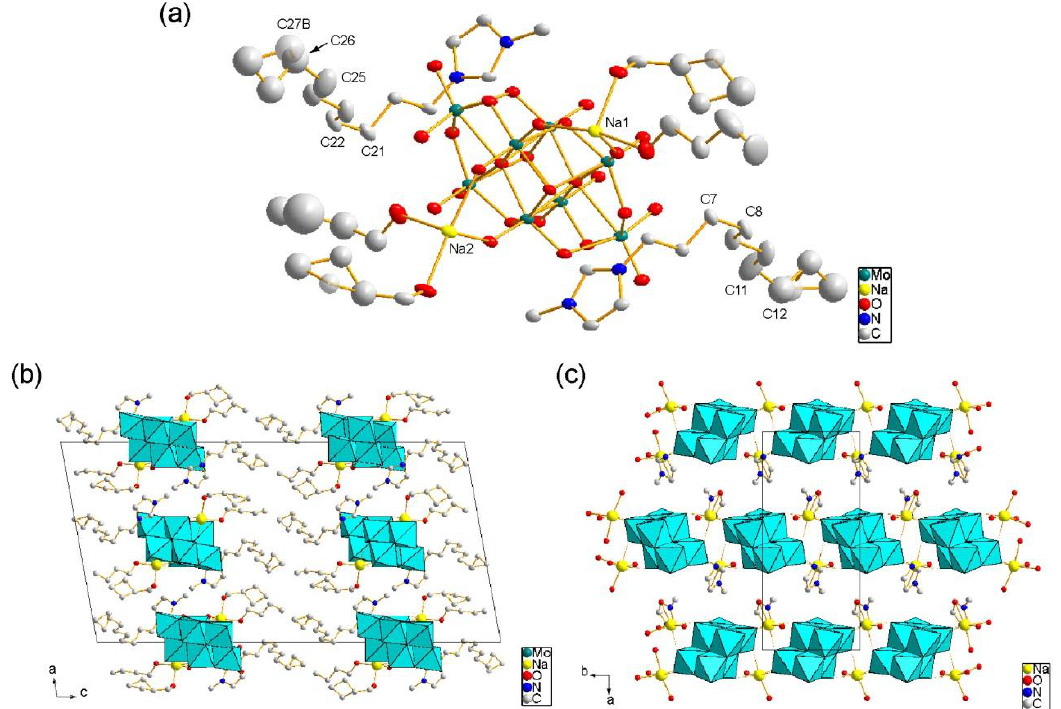
Figure 1. Crystal structure of C im-Na-Mo . H atoms are omitted for clarity. 10 8 ( a ) Asymmetric unit drawn by displacement ellipsoids at the 30% probability level. Minor parts of the disordered C atoms are indicated in transparent color; ( b ) Packing diagram along b axis (Mo in polyhedral representations); ( c ) Molecular arrangements in 8 the inorganic layers. The decyl and butyl groups are omitted for clarity.